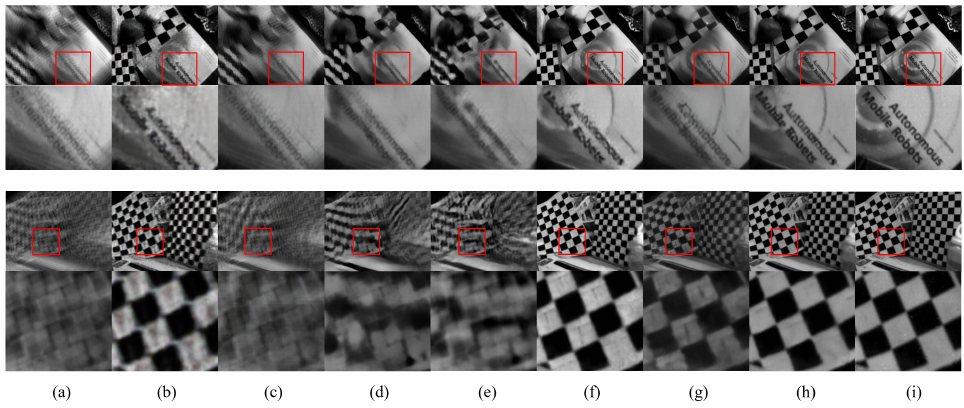
Figure 7. Qualitative comparison of the results using the HQF real dataset. ( a ) Input blurred image. ( b ) E2VID [21]. ( c ) STFAN [5]. ( d ) CDVD-TSP [8]. ( e ) ESTRNN [10]. ( f ) LEDVDI [12]. ( g ) D 2 Net [13]. ( h ) Proposed MEVDNet. ( i ) Ground